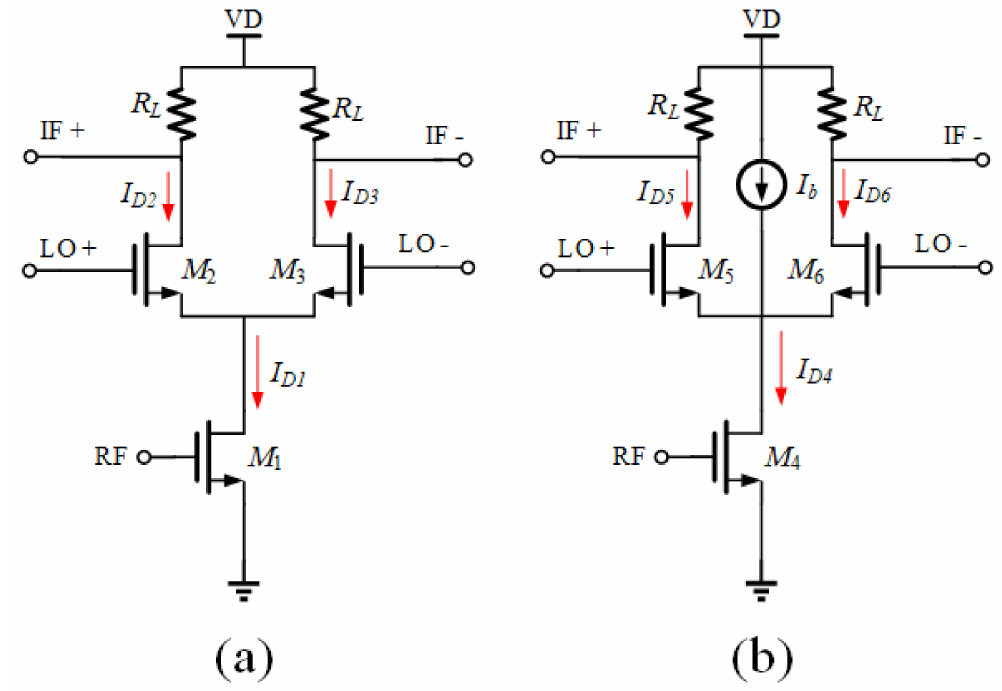
Figure 5. ( a ) Conventional single-balanced mixer; ( b ) single-balanced mixer with current-bleeding technology.